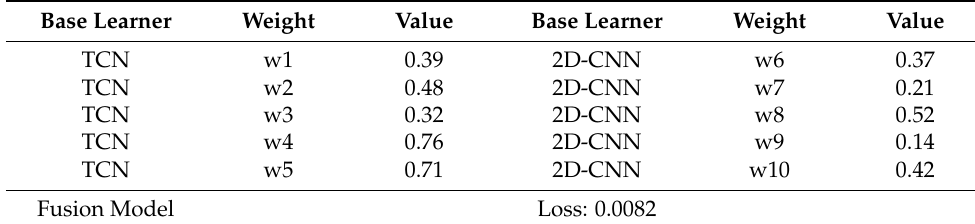
Table 6. Optimal weighting values searched by particle swarm search algorithm.